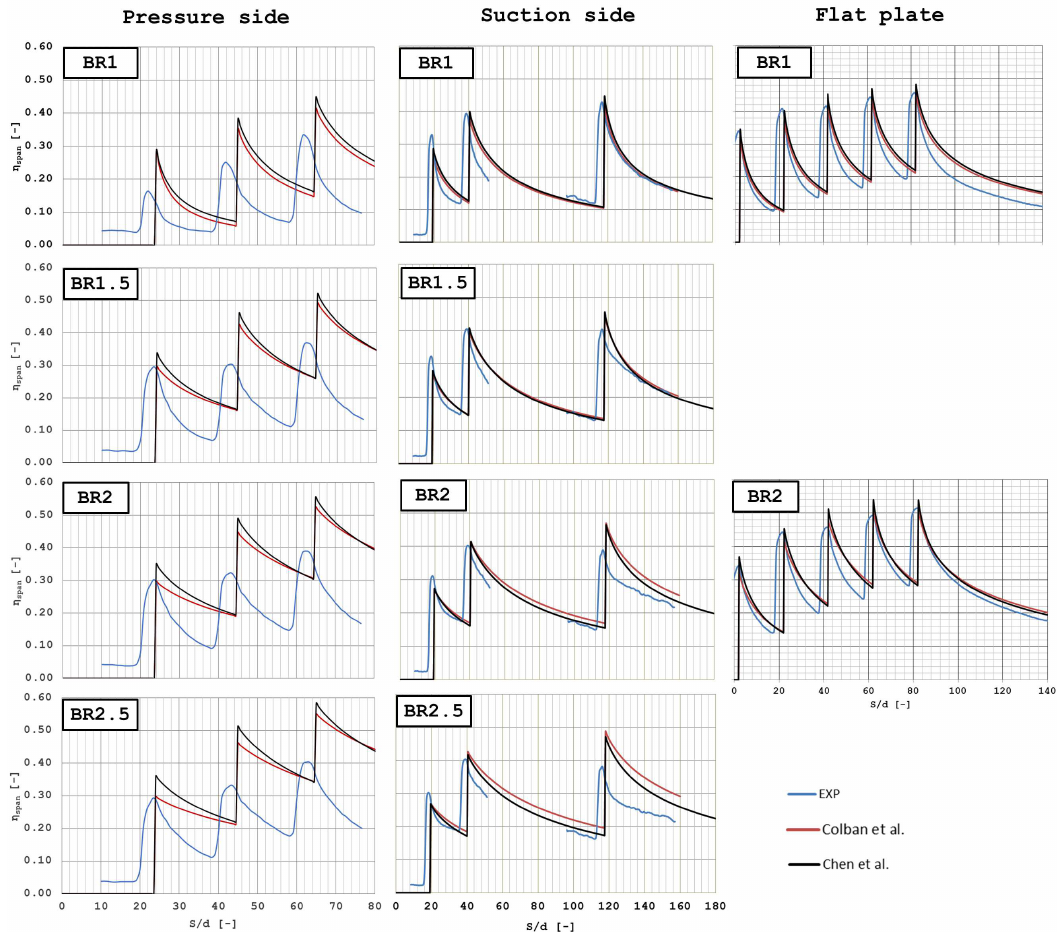
Figure 8. Spanwise average effectiveness 1D profile: comparison with